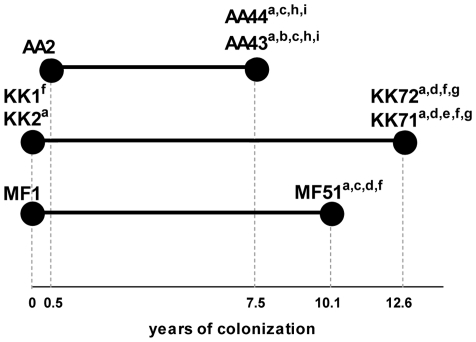
Genotypic and phenotypic characteristic of P. aeruginosa sequential isolates from CF patients.Three clonal lineages (AA, KK and MF) of P. aeruginosa strains were isolated at the onset of chronic colonization (early: AA2, KK1, KK2, MF1) or several years after acquisition and before patient's death (late: AA43, AA44, KK71, KK72, MF51). Clonality of strains was assessed by Pulsed Field Gel Electrophoresis and was reported previously [4]. Multiple phenotypic traits changed during genetic adaptation to the CF lung and included [14]: (a) motility defect, (b) mucoid phenotype, (c) protease reduction, (d) siderophore reduction, (e) hemolysis reduction, (f) LasR phenotype, (g) growth rate reduction. In addition, lipopolysaccharide (LPS) lipid A (h) and peptidoglycan (PGN) muropeptides (i) were analysed exclusively in the lineage AA showing specific structural modifications temporally associated with CF lung infection as described previously [5]. Additional data were reported in the online data supplement (Table S1).